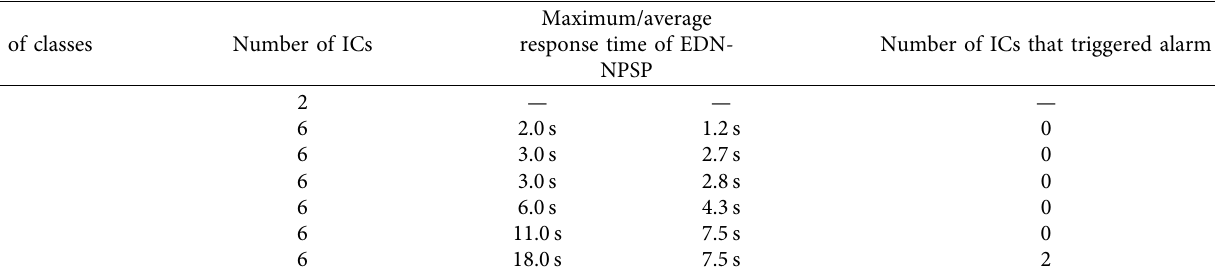
Figure 12: SSIM of state prediction network for test samples (prediction time: 30s). Table 3: Simulation industry conditions for EDN-NPSP test.